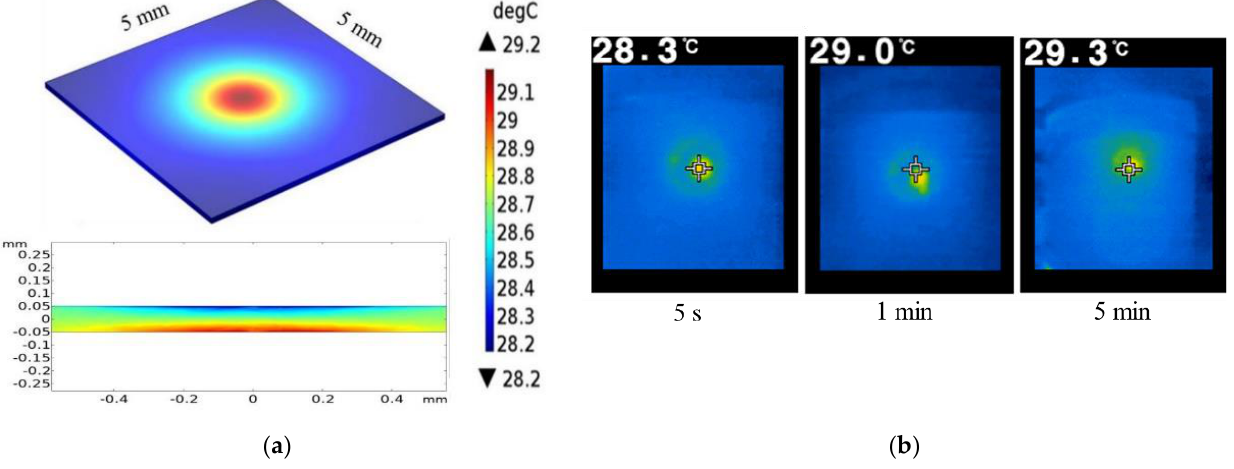
Figure 2. ( a ) Numerical contours of temperature field distribution in liquid layer. ( b ) Experimental temperature measurements in area of laser illumination after 5 s, 1 min, and 5 min. Note that the laser power is 75 W/cm 2 , the voltage amplitude is 35 V pp , and the driving frequency is 25 kHz.